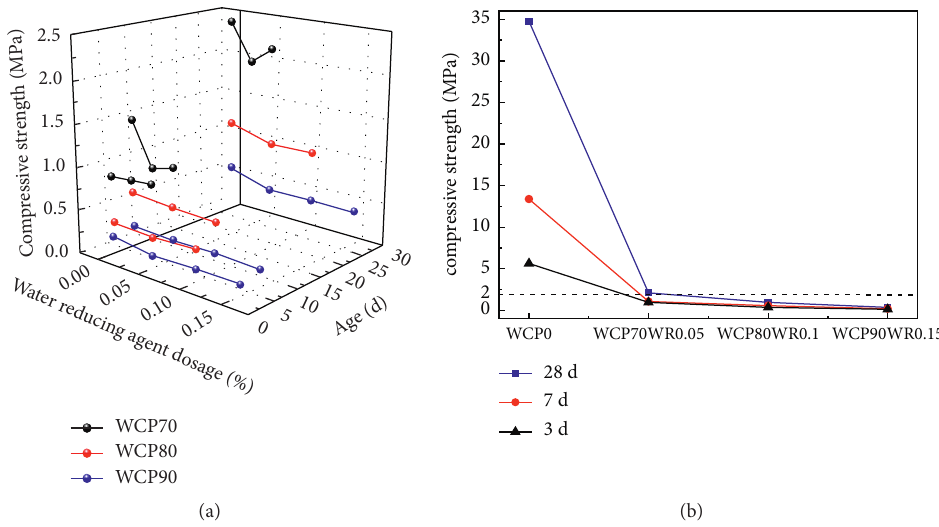
Figure 12: Compressive strength of test samples at different water-reducing agent dosages: (a) change rule and (b) comparison of slurries with similar viscosity.